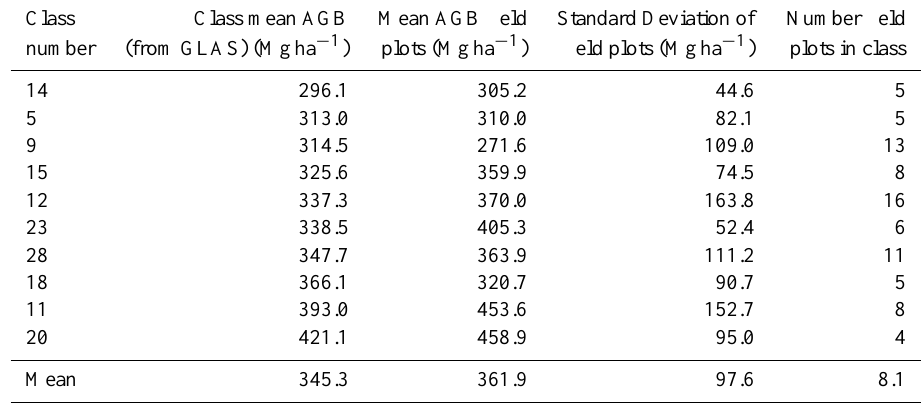
Table 3. Comparison of mean AGB for classes from LiDAR with mean AGB from field plots found within these